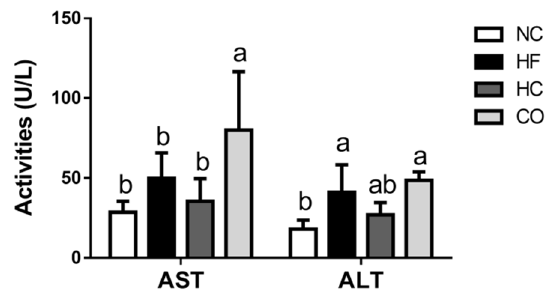
Figure 1. The changes in plasma aspartate aminotransferase (AST) and alanine aminotransferase (ALT) activities in rats fed with different experimental diets after 12 weeks. Data are expressed as the mean ± S.D. for each group ( n = 8). Values with different superscript letters (a, b) are signifi- cantly different from each other ( p < 0.05). NC: Normal control diet (chow diet). HF: High-fat diet (chow diet + 10% lard). HC: HF diet + 5% high-molecular-weight chitosan. CO: HF diet + 5% chi- tosan oligosaccharides.